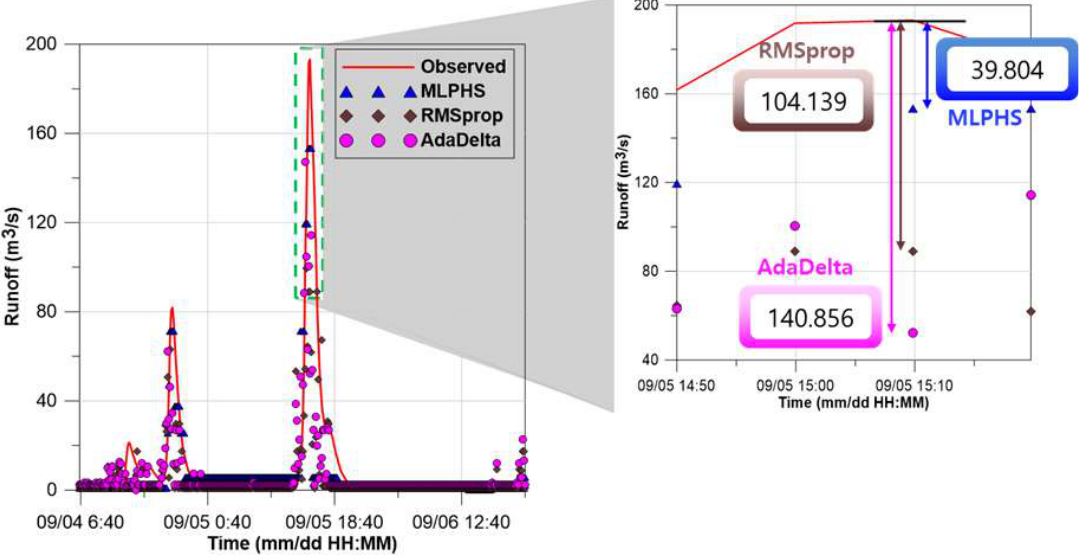
Figure 5. Comparison of the results obtained with AdaDelta, RMSprop, and HS (MLPHS). Additionally, notable results occurred at the peak value of the observed runoff.